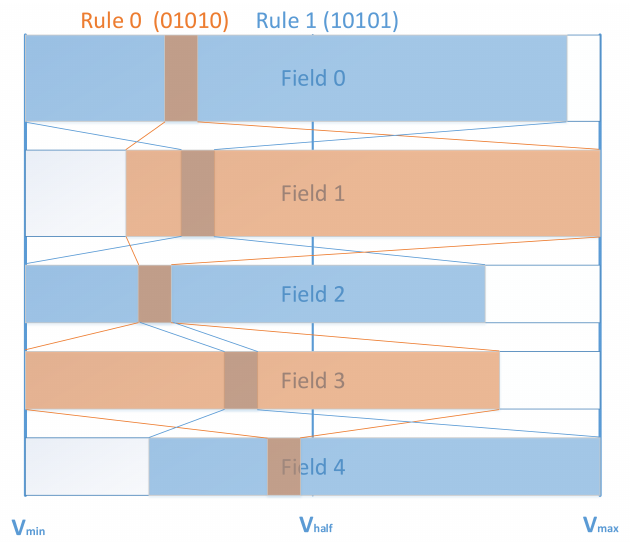
Figure 3. An example of Complementary